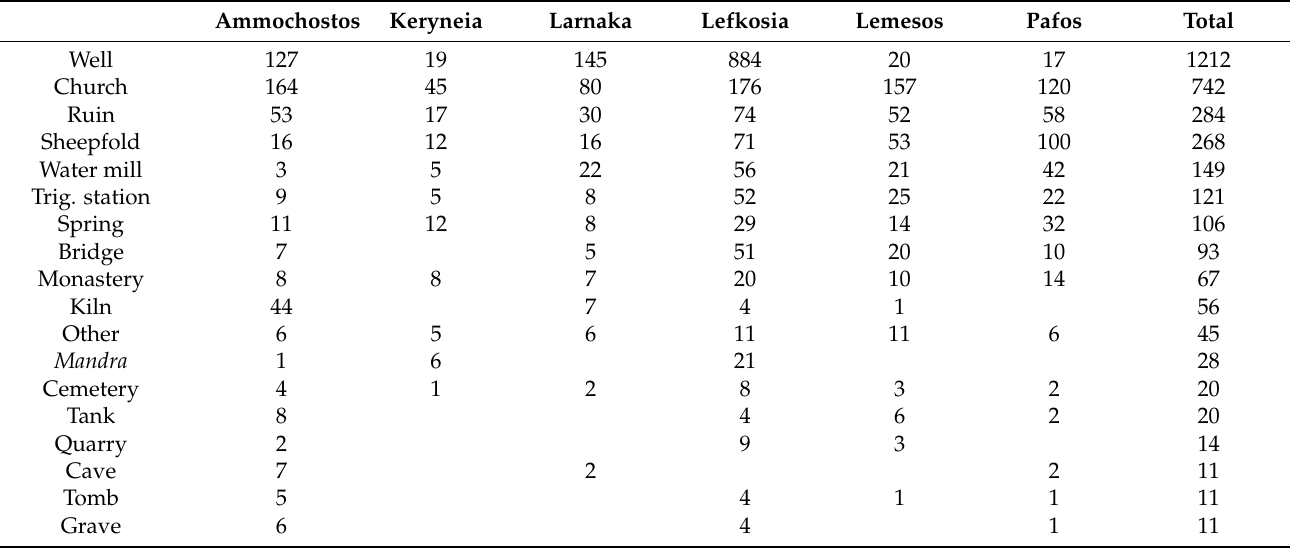
Table 4. Landmarks collected across administration